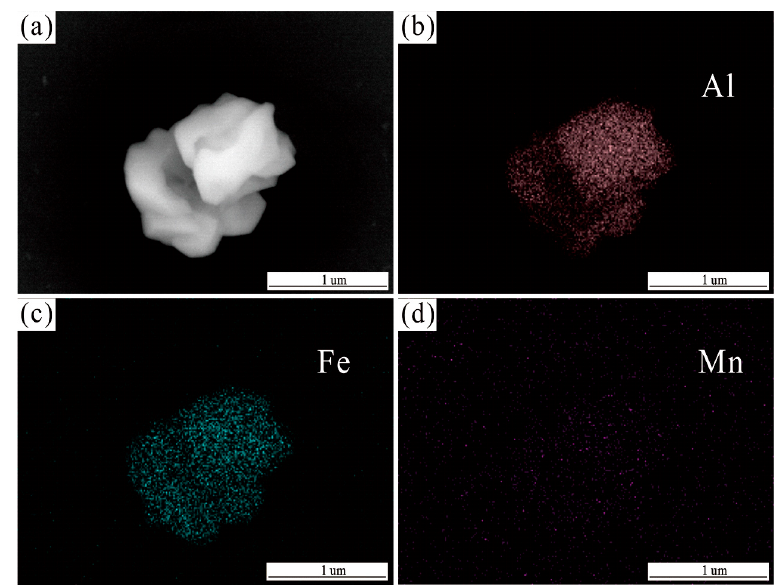
Figure 7. ( a ) BSE images of the representative Al-Fe phase in the etched Mg-3Al alloy by SEM. ( b )–( d ) energy dispersive X-ray spectroscopy (EDX) maps showing Al, Fe, and Mn elemental distributions, respectively, in the particle.